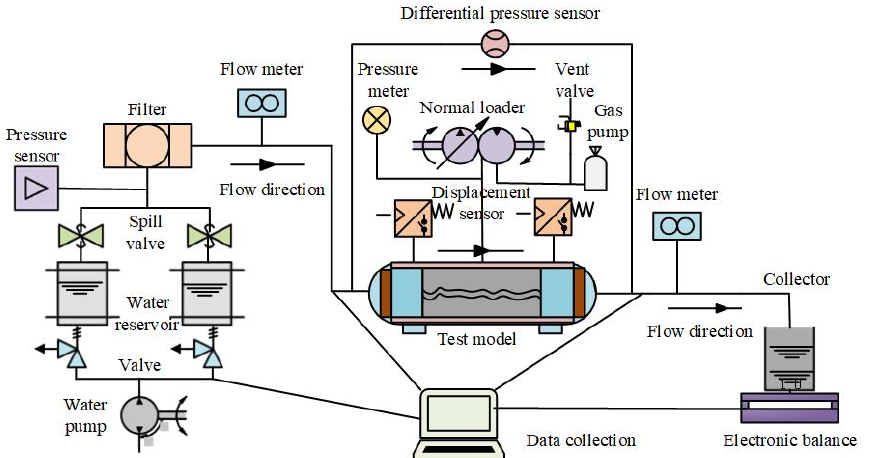
Figure 5. Fracture seepage testing system.